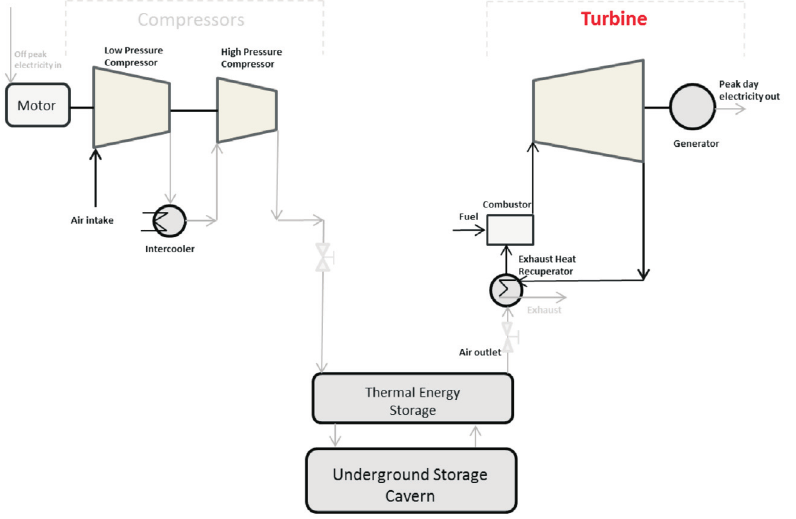
Fig. 1. a CaES system with exhaust heat storage, combustion chamber and recuperator [1] Rys. 1. Układ CAES z magazynem ciepła odpadowego, komorą spalania i rekuperatorem